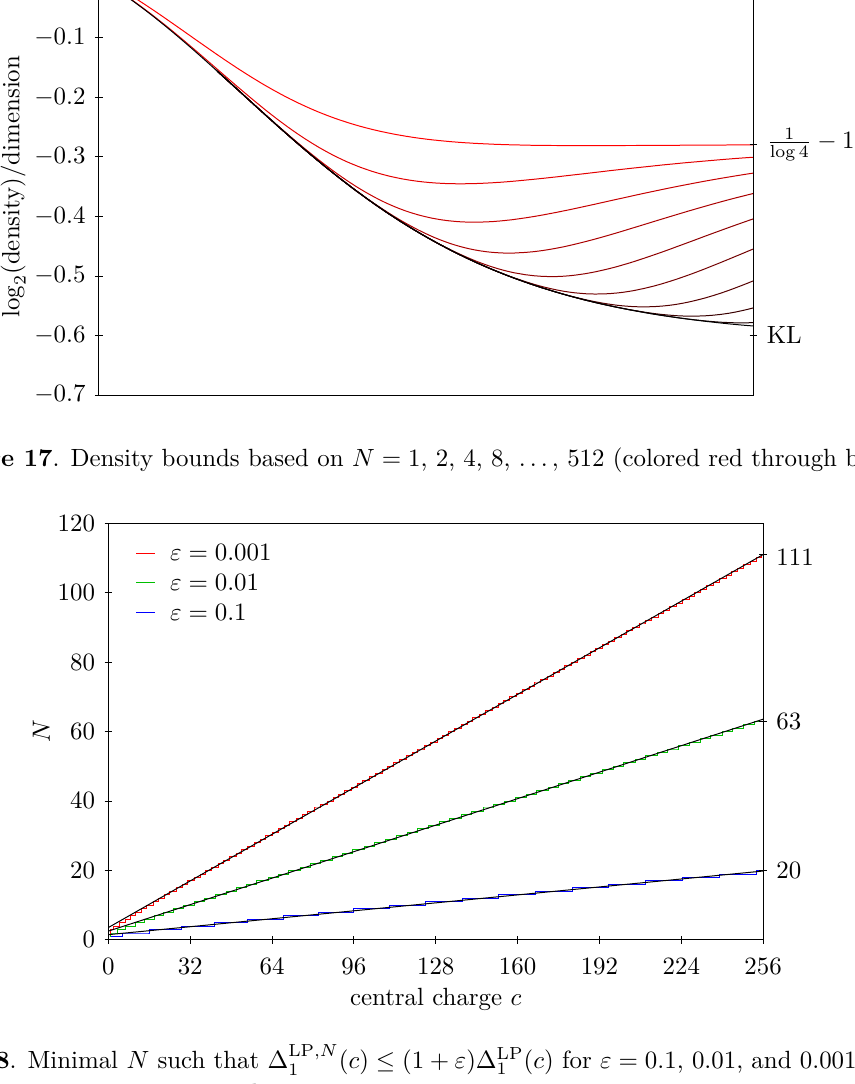
( c ) ≤ (1 + ε )∆ LP ( c ) for ε = 0 . 1 , 0 . 01 , and 0 . 001 , together 1 1